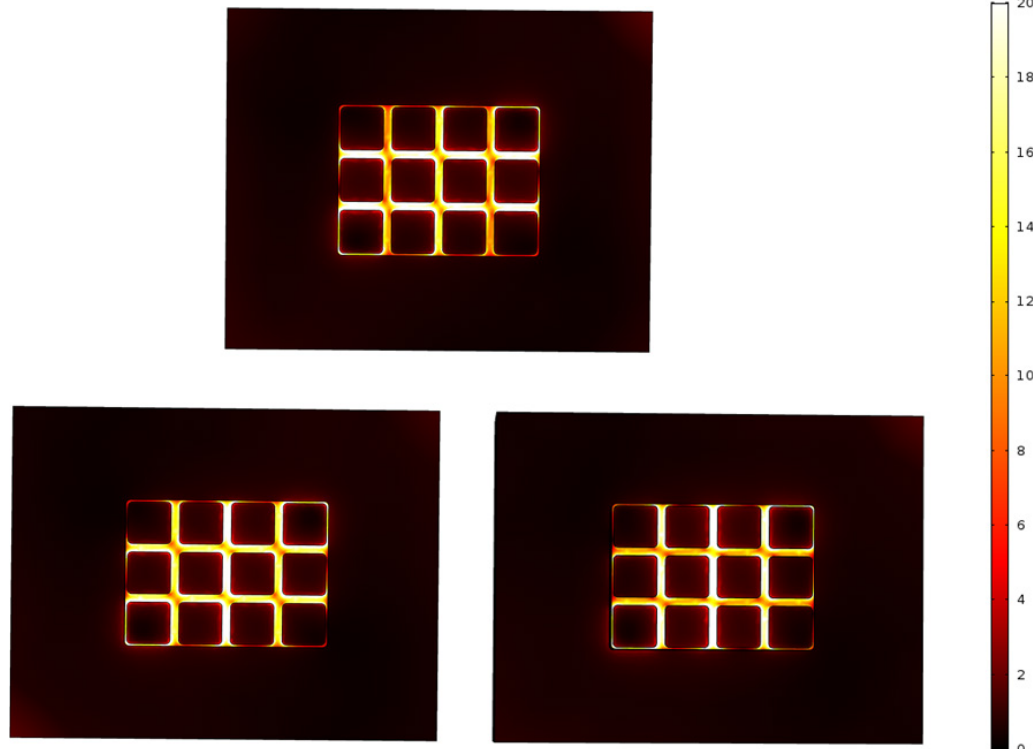
Figure S2: Electric field distribution on the x-y section with D=30nm and various polarization: (a) π 6 ; (b) π 4 ; (c) π